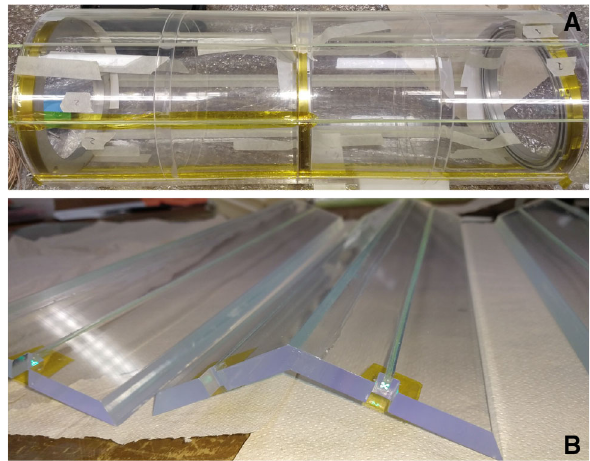
Fig. 5 a OV cylinder picture where the grooves for the WLS fibers are clearly visible. b Scintillator bars forming the IV lateral